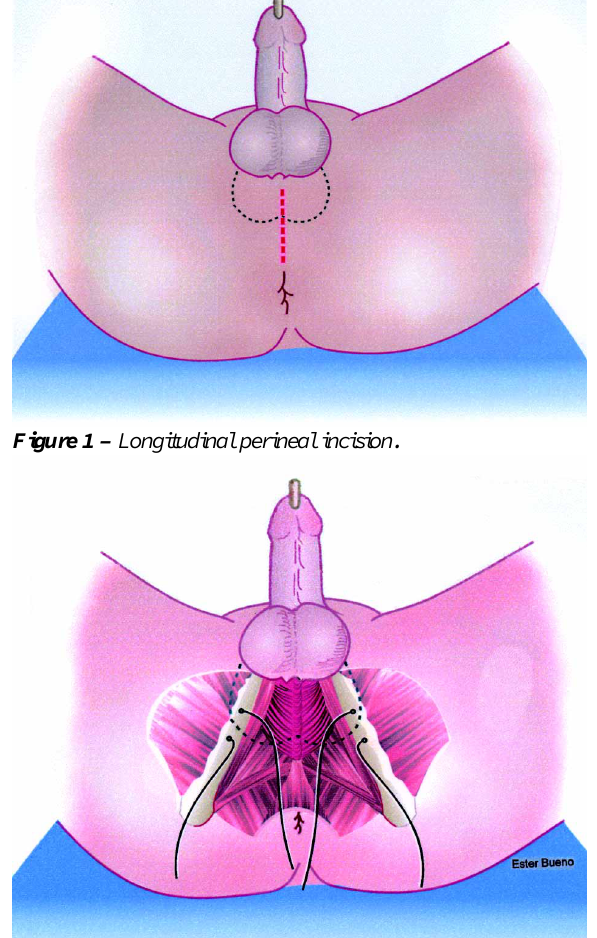
Figure 2 – Anchors applied to ischiopubic rami bilaterally.